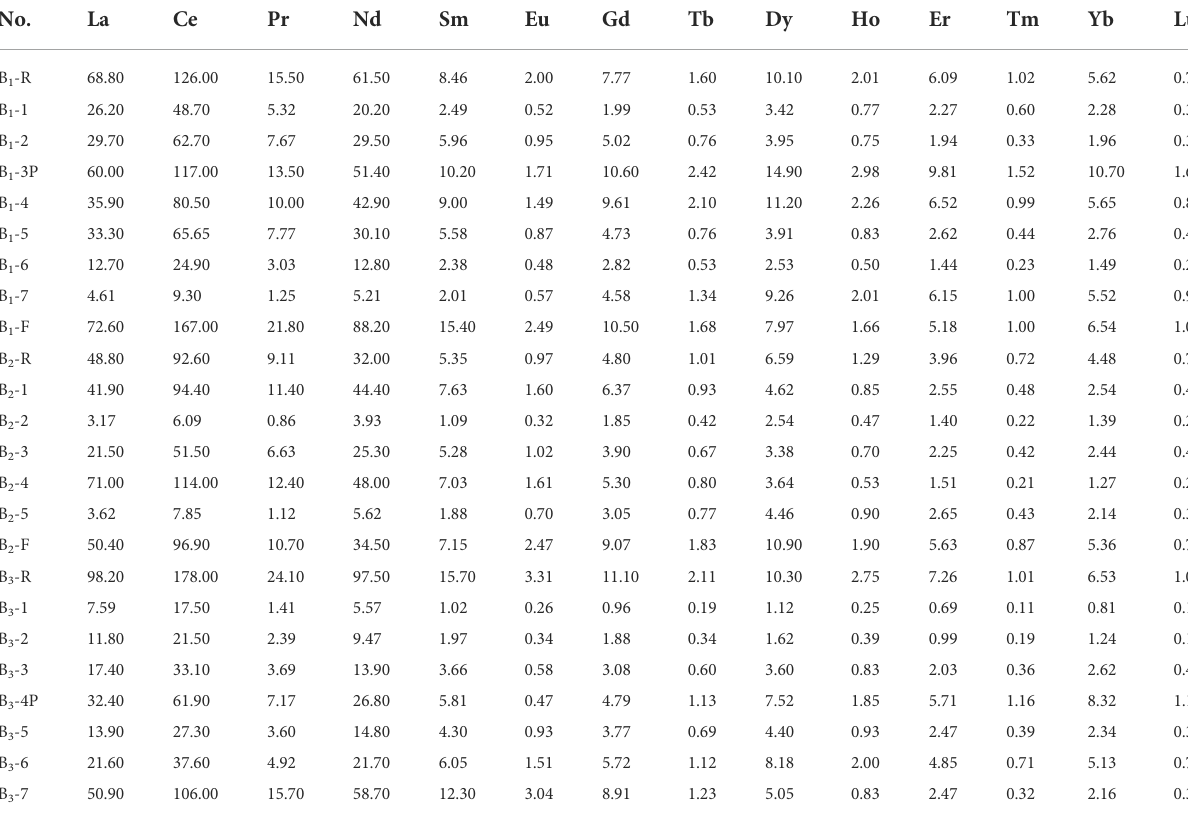
TABLE 2 REE contents of the late permian coal seam samples from the Yantang Mine, Xuanwei, Yunnan (µg/g).